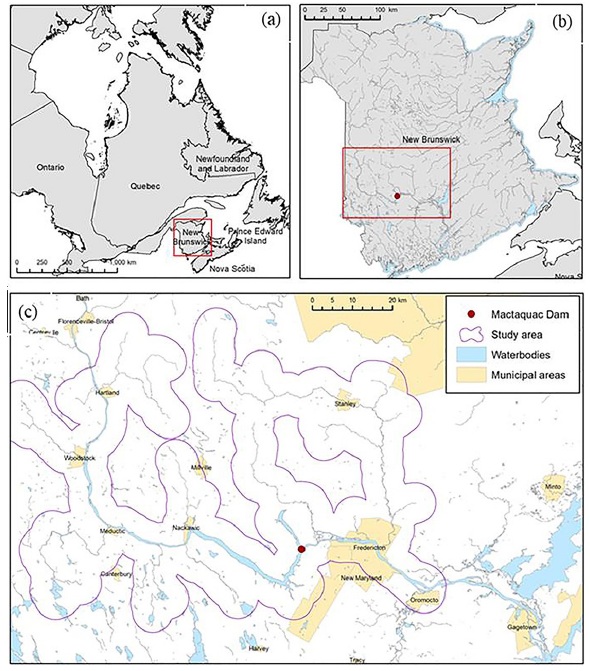
Fig. 2. Location of the study area in Canada (A) and New Brunswick (B). (C) Boundaries of the study area (purple line) were defined as a 5000-m buffer around the reach of the river most hydrologically affected by the dam and its tributaries (approximately Hartland to Oromocto). Produced in ArcGIS 10.4 (ESRI 2016) and contains information licensed under the GeoNB Open Data Licence and under the Open Government Licence – Canada, as well as data from Natural Earth. Source: Reilly et al.